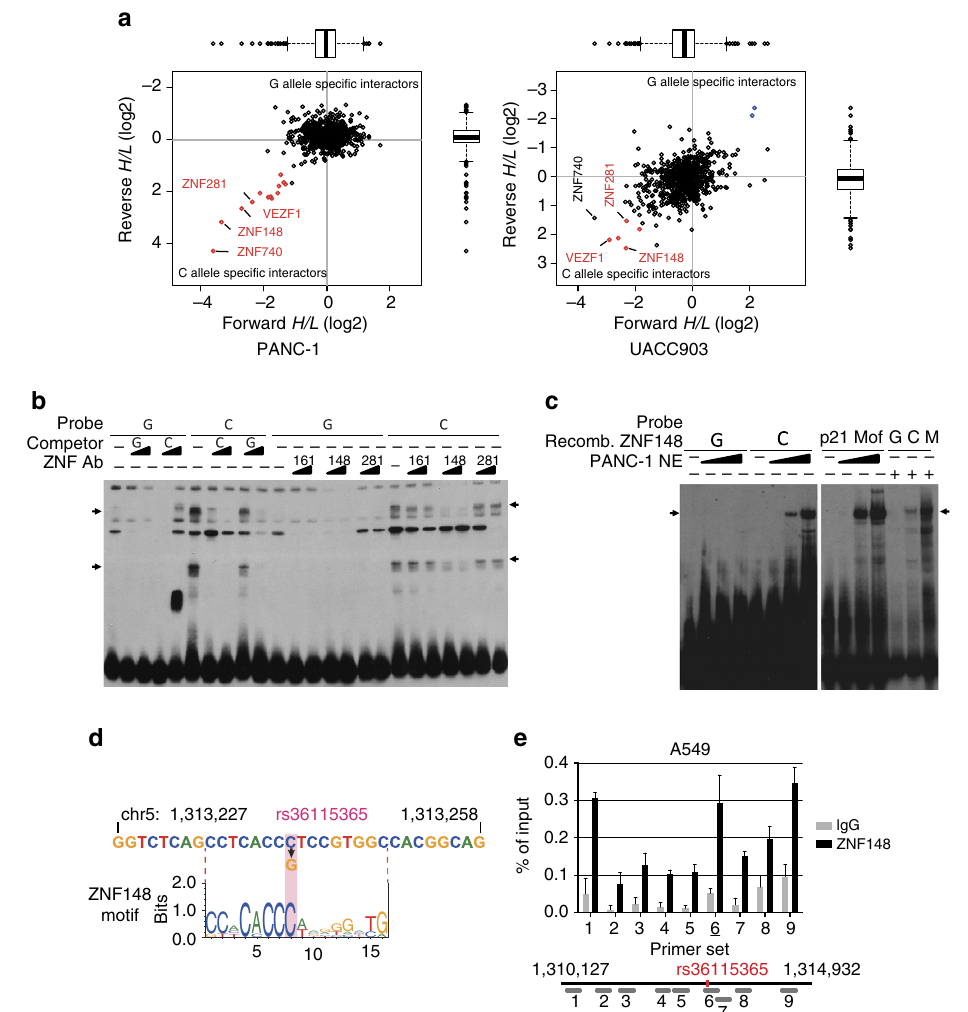
Figure 5 | ZNF148 is an allele-specific interactor of rs36115365. ( a ) DNA pulldowns were performed using PANC-1 (pancreatic cancer) and UACC903 (melanoma) cell line nuclear extracts with 41bp biotin-tagged rs36115365 bait oligos. Replicate label-swapping experiments were performed with poly-dAdTcompetitor. Ratios indicate enrichment for protein binding to either the C- or G-allele. Significantly enriched ratios in both a forward and reverse label-swapping experiment were called as outliers (red: C-allele; blue: G-allele. Outlier cutoff is 1.5 IQRs). Identities of C-allele preferential binding proteins identified as outliers. Boxes in boxplots represent first to third quartiles and whiskers extend to furthest data point still within 1.5 IQRs of either quartile. ( b ) EMSA was performed with oligonucleotides containing the C or G allele at rs36115365 using nuclear extract from PANC-1 pancreatic cancer cells. The left side (lanes 1–10) shows preferred binding of two protein complexes to the C allele of rs36115365; the right side (lanes 11–24) competition of binding to the C allele by antibodies specific for three zinc finger proteins: VEZF1/ZNF161, ZNF148/ZBP-89 and ZNF281. The gradient symbol indicates 1 or 2 m g antibody used for competition. An antibody to ZNF148/ZBP-89 competes efficiently for binding of a protein to the rs36115365-C oligonucleotide. ( c ) EMSA showing binding of recombinant human ZNF148 to the C allele of rs36115365 (lanes 1–8). A ZNF148 binding site in the CDKN1A/p21 promoter (p21 Motif, M) was used as a positive control (lanes 9–12), as well as PANC-1 nuclear extract (lanes 13–15). Arrows denote proteins bound by the C allele of rs36115365. The gradient symbol indicates addition of 90, 360 or 630ng of recombinant ZNF148 to the reaction. ( d ) rs36115365 alters a predicted ZNF148/CACCC-binding protein DNA recognition motif (Transfac motif M00721). ( e ) Chromatin immunoprecipitation (ChIP) using an antibody against ZNF148 (black bars) in the A549 lung cancer cell line revealed enrichment of ZNF148 binding at rs36115365 (amplicon #6) over background levels using a nonspecific IgG antibody (grey bars). The location of amplicons tested with qPCR relative to rs36115365 are shown underneath the graph (drawn to scale). PCRs were conducted in triplicate and repeated for each of two immunoprecipitations; error bars represent standard deviation (s.d.) for a representative